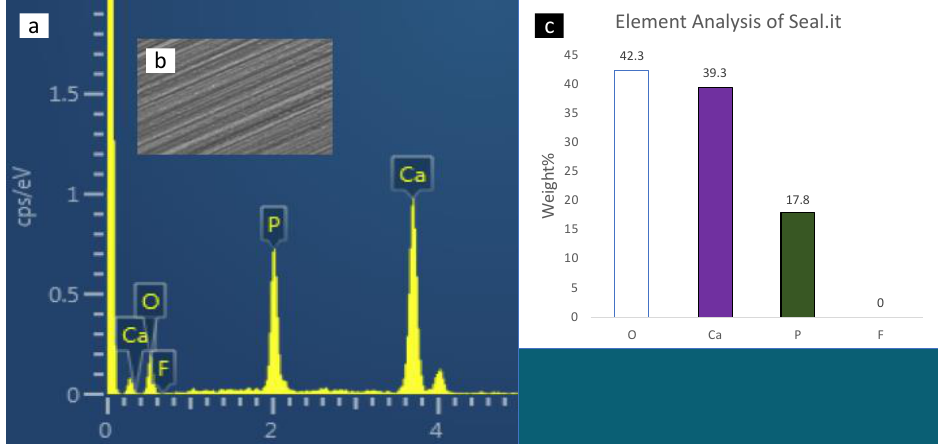
Figure 5. The SEM-EDX evaluation of the enamel samples under Seal-it: ( a ) the SEM-EDX spectrum shows the dominant elements; ( b ) SEM image of the area for which the EDX spectrum was acquired; ( c ) concentrations of elements in weight (weight percent) of the oxygen, calcium, phosphate and fluoride elements found in enamel surface under the sealants.